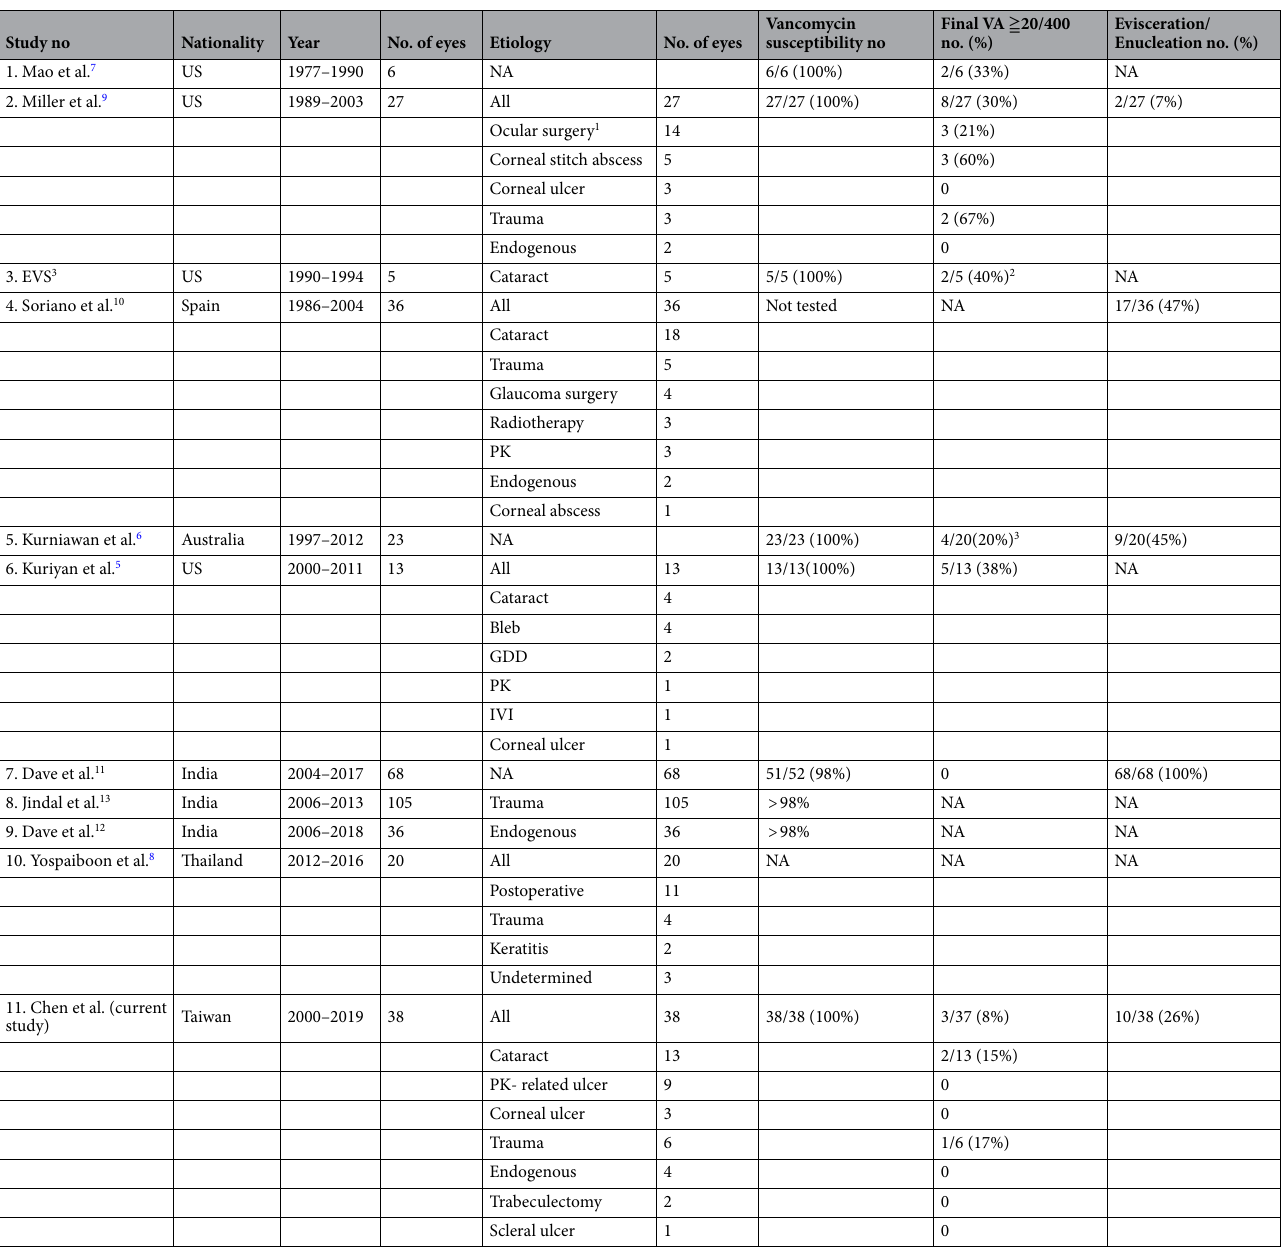
Table 5. Comparison in patients with Streptococcus pneumoniae in literature and present study. GDD glaucoma drainage device; IVI intravitreal injection; NA not available; PK penetrating keratoplasty. 1 Ocular surgery: Cataract extraction (5), bleb-associated (4), lensectomy/anterior vitrectomy (1), bleb needling (1), suture removal (1), penetrating keratoplasty (1), glaucoma drainage device (1). 2 Final VA ≧ 5/200. 3 Final VA >